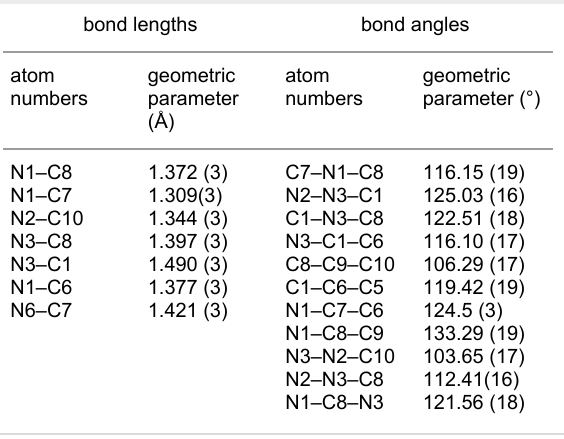
Table 2: Selected bond lengths and bond angles for compound 6a